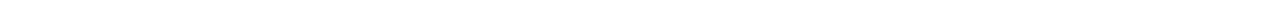
Fig. 3 mPGC-1 α suppresses metabolic reprogramming in injured kidney after 7 days FAN. a Cellular respiration was examined in fresh isolated tubules from kidneys of Wt sham and mPGC-1 α sham mice by measuring Oxygen Consumption Rate (OCR) and Extracellular Acidi fi cation Rate (ECAR) using XFe24 extracellular fl ux analyzer. b Cellular respirations in fresh isolated tubules form Wt and mPGC-1 α mice with FAN c Measurements of basal OCR in each group as indicated. d Measurements of Maximal respiration and Spare respiration rate (percentage of basal respiration), and Basal ECAR in each group. Data ( c , d ) was presented as mean ± s.e.m.; * P < 0.05 or ** P < 0.01 for Wt-FAN vs. Wt-Sham and # P < 0.05 for mPGC-1 α -FAN vs. Wt-FAN, n = 5 per group (one-way ANOVA with Bonferroni ’ s multiple comparison test). e Metabolomics analysis of kidney cortex form each group as indicated. Heat map shows relative levels of metabolites in kidneys from mice each group ( n = 3). f – h Statistical analysis of representative metabolites in glycolysis pathway, fatty acid metabolism and Krebs cycle. * P < 0.05 or ** P < 0.01 or *** P < 0.001 for Wt-FAN vs. Wt-Sham. # P < 0.05 for mPGC-1 α -FAN vs. Wt-FAN ( n = 3 per group, one-way ANOVA with Bonferroni ’ s multiple comparison test). i and j Real-time qPCR analysis of enzymes expression in glycolysis pathway or Fatty Acid oxidation pathway. * P < 0.05 or ** P < 0.01 for Wt-FAN vs. Wt-Sham. # P < 0.05 or ## P < 0.01 for mPGC-1 α -FAN vs. Wt-FAN ( n = 5 per group, one-way ANOVA with Bonferroni ’ s multiple comparison test). k ATP concentration in kidney cortex tissue from normal mice or mice treated with FAN. Data were presented as mean ± s.e.m.; ** P < 0.01 for Wt-FAN vs. Wt-Sham. * P < 0.05 for mPGC-1 α -FAN vs. mPGC-1 α -Sham. # P < 0.05 for mPGC-1 α -FAN vs. Wt-FAN ( n = 5 per group, one-way ANOVA with Bonferroni ’ s multiple comparison